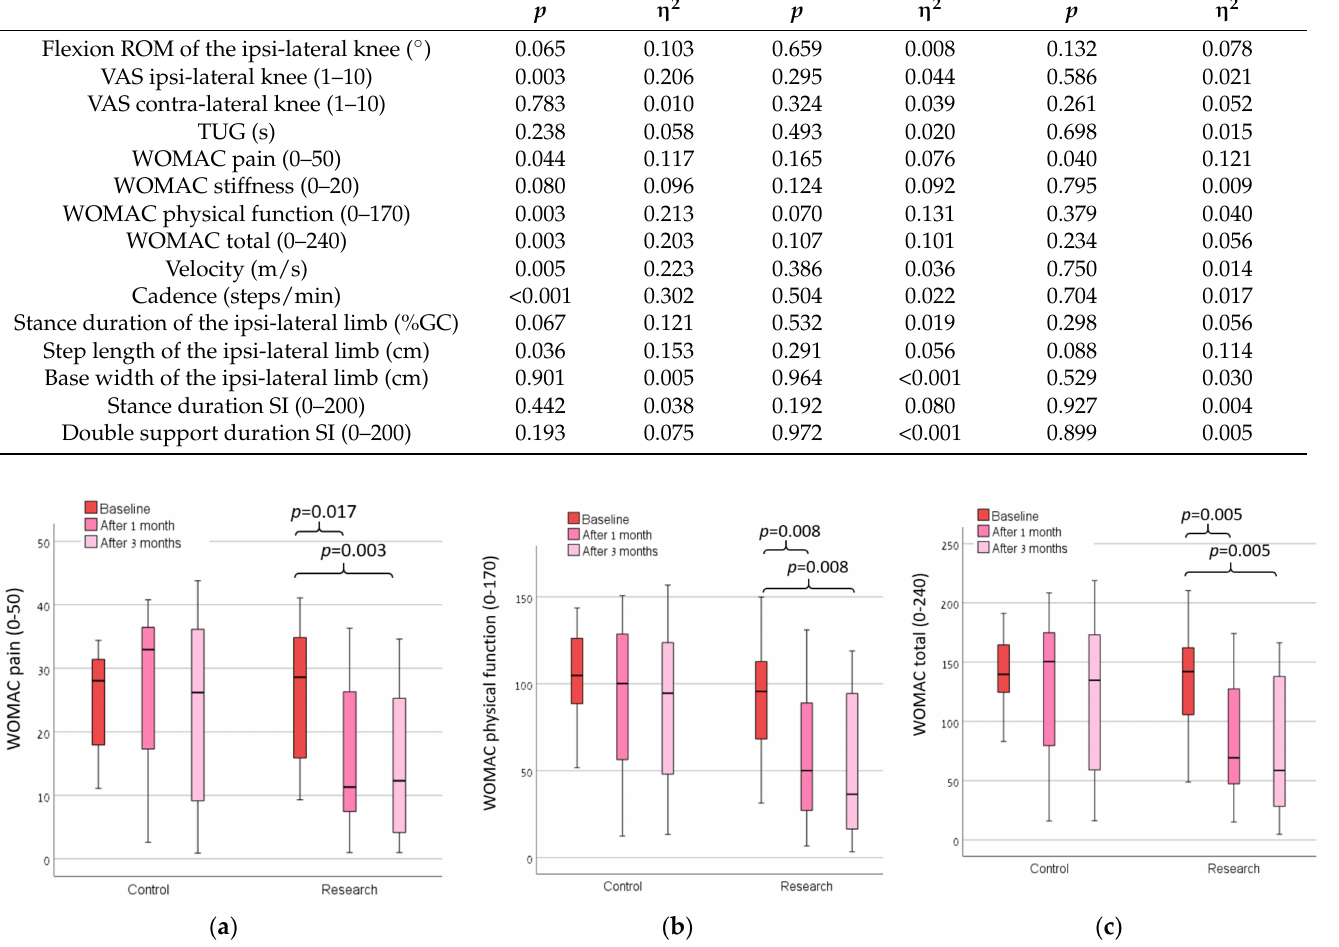
Figure 3. The Western Ontario and McMaster Universities Arthritis Index (WOMAC) for ( a ) pain, ( b ) physical function and ( c ) total score of both groups at baseline, 1 month and 3 months after the